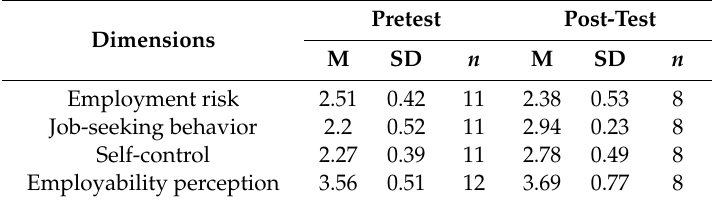
Table 4. Descriptive statistics.